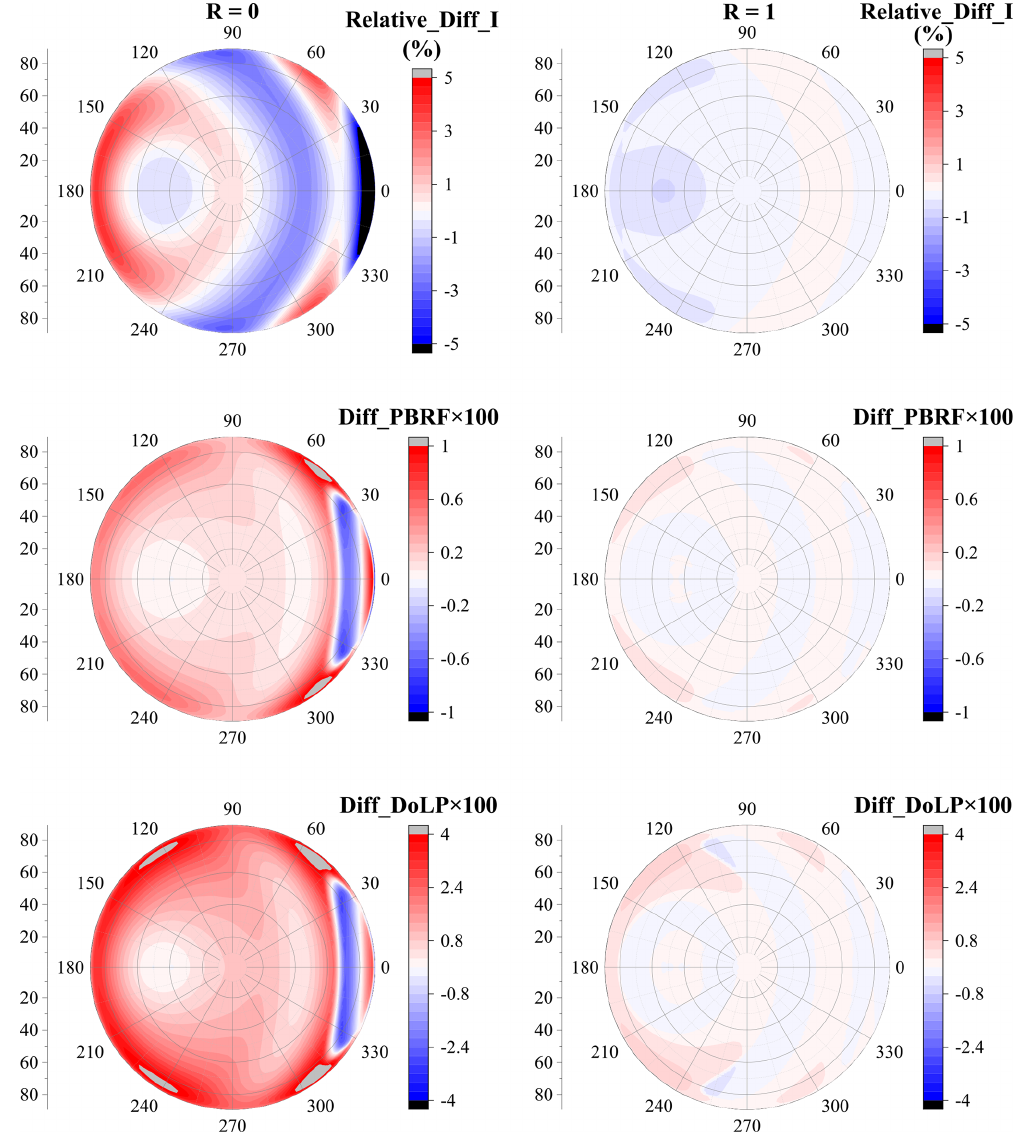
Figure 16. The difference of polarimetric characteristics between dust with irregular shapes and best-fitted spheroids, where the aspect ratio is 2 : 1, f = 0 . 8 and d p = 0 .